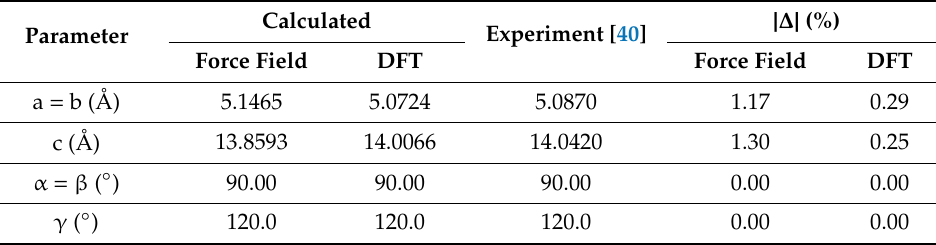
Figure 1. Crystal structure of rhombohedral ilmenite (FeTiO 3 ) . Table 1. Calculated structural parameters and corresponding experimental values reported for rhombohedral FeTiO 3